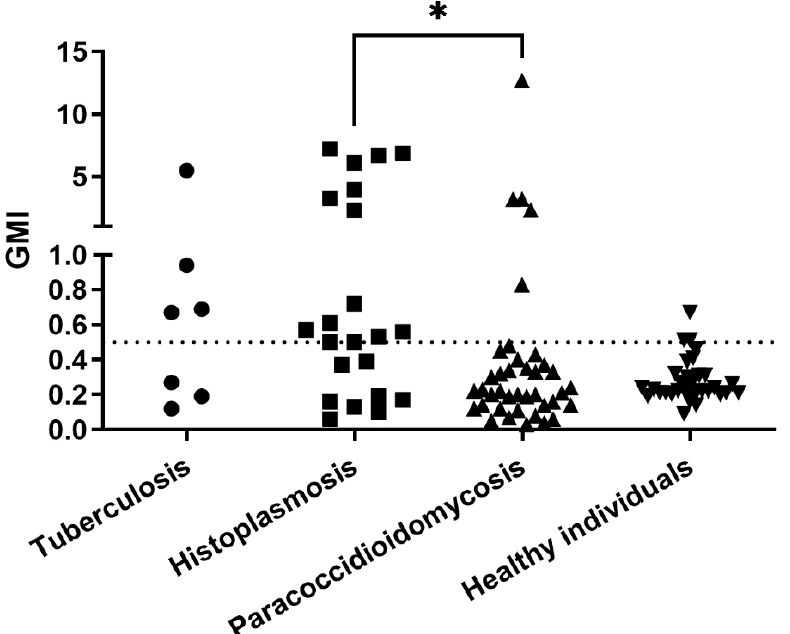
Figure 5. Galactomannan indexes of 100 individuals without aspergillosis tested with the Bio-Rad Platelia sandwich ELISA. The dotted line represents the cut-off recommended by the manufacturer. Significant difference, tested by the Dunn’s multiple comparison test, is represented. * p < 0.05, GMI = galactomannan index.